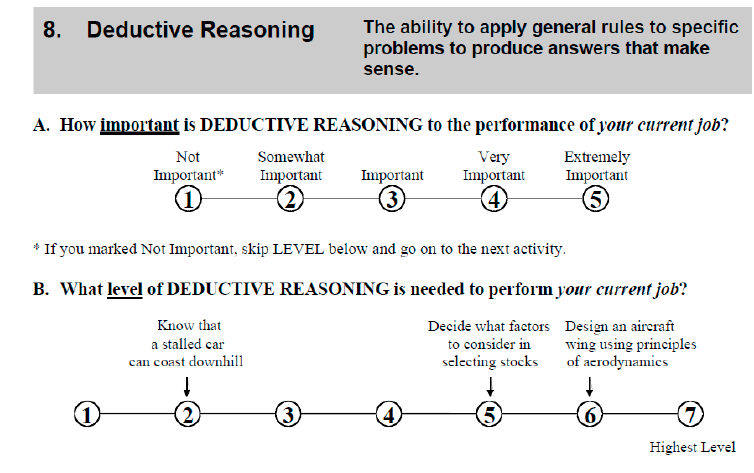
Figure 1. Sample knowledge item from the O*NET Knowledge Questionnaire.